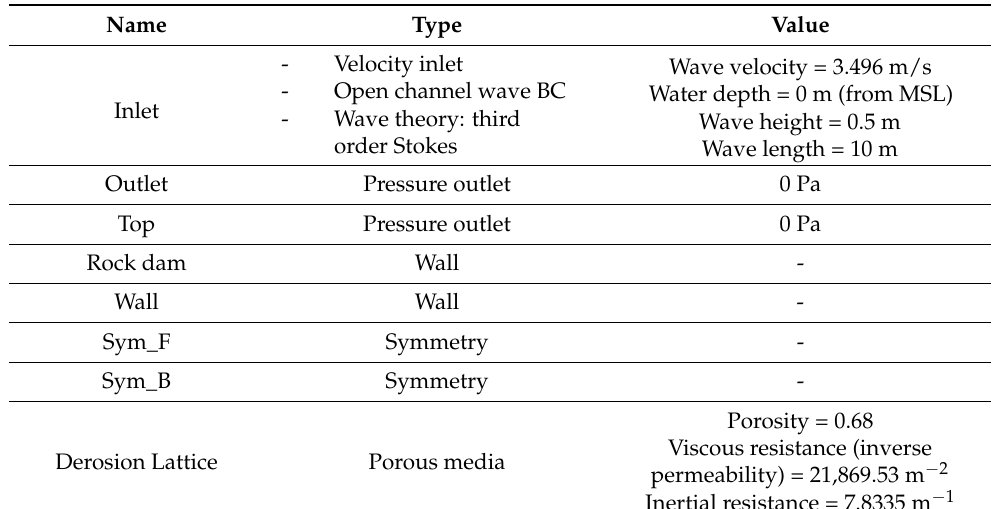
Figure 9. The boundary conditions. Table 2. The essential parameters setting for boundary conditions.